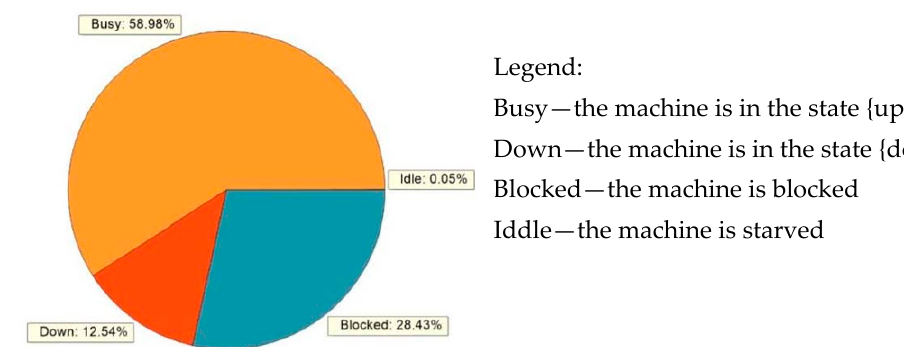
Figure 19. An example of the simulation output results.